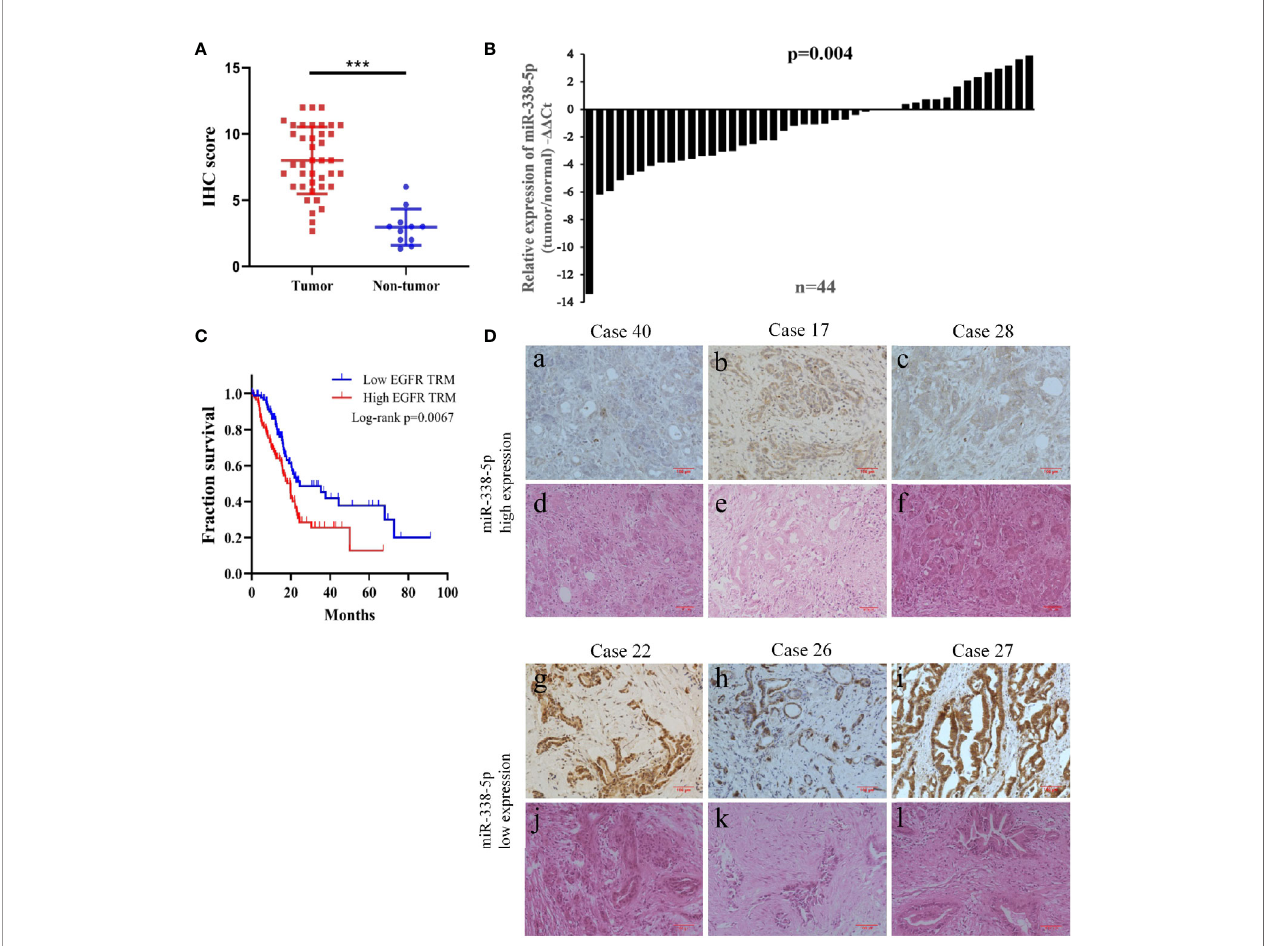
FIGURE 1 | The low expression of miR-338-5p in PC tissues was negatively correlated with EGFR expression. (A) The expression of EGFR in the tumor tissues and normal tissues was evaluated by immunohistochemistry. (B) miR-338-5p levels were detected in 44 paired PC tissues by qRT-PCR. (C) EGFR high expression was correlated with a poor survival rate of pancreatic cancer patients (n = 174, P < 0.01). Data was analyzed using Kaplan Meier curve (D) The IHC results of EGFR and HE staining in corresponding PC tissues. (a – c) A low expression level of EGFR was observed in tissues with high expression levels of miR ‐ 338-5p. (g – i) A high expression level of EGFR was observed in tissues with low expression levels of miR ‐ 338-5p. (d – f, j – l) H&E staining results corresponding to a, – c, g – i. ***P <